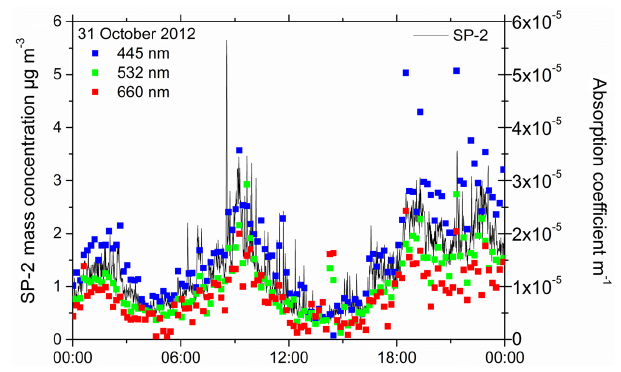
Figure 8. SP-2 incandescence mass concentrations (black line) and photoacoustic absorption coefficients (blue, green, red squares) for 1 day in fall 2012, Karlsruhe,